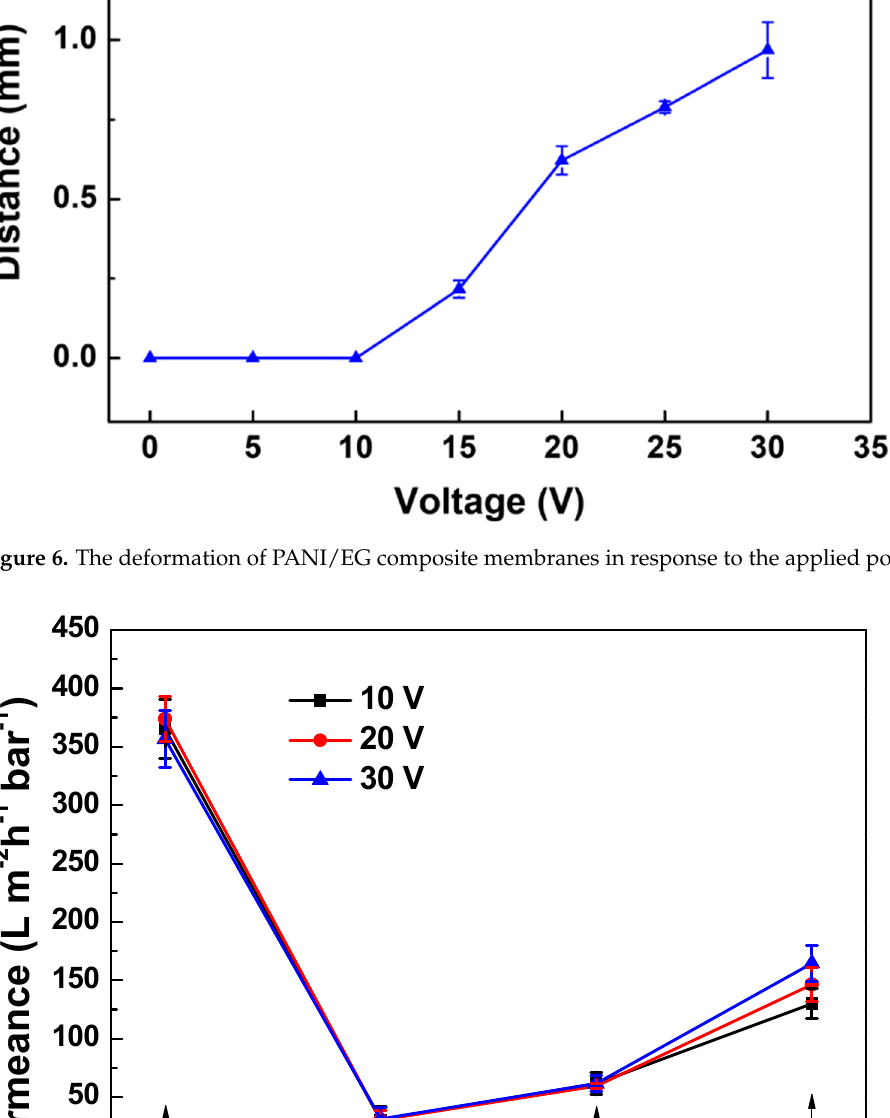
Figure 8. Permeance of PANI/EG composite membranes (virgin, BSA fouled, after fouled and cleaned) under the applied potential of 30 V at two cycles (C1-1 = virgin (Cycle 1), C1-2 = BSA fouled (Cycle 1), C1-3 = after fouled (Cycle 1) and C1-4 = cleaned (Cycle 1); C2-1 = virgin (Cycle 2), C2-2 = BSA fouled (Cycle 2), C2-3 = after fouled (Cycle 2) and C2-4 = cleaned (Cycle 2)). Experimental con- ditions: applied potential 30 V, operating pressure 2 bar, [BSA] = 1.0 g L –1 , room temperature. BSA concentration in the wash solution was also measured to evaluate the foulants washed away from the membrane and to further confirm the fouling removal behaviour under applied potential. BSA concentration in the wash solution of PANI/EG composite membranes with time was displayed in Figure S7 (supplementary material). The mem- brane showed a significant fouling removal response in the first 90 min and the BSA con- centration in the wash solution was steadily improved with time. There was no obvious